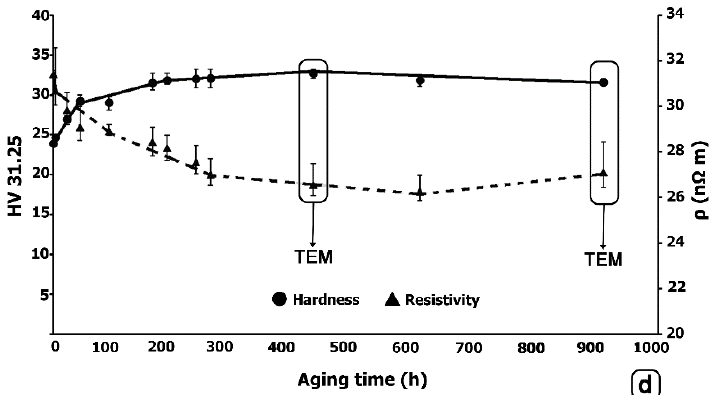
Figure 4. Hardness and electrical resistivity. ( a ) Alloy-I aged at 380 ◦ C; ( b ) Alloy-I aged at 400 ◦ C; ( c ) Alloy-II aged at 380 ◦ C; ( d ) Alloy-II aged at 400 ◦ C. In the last figure, the samples analyzed by TEM are marked.